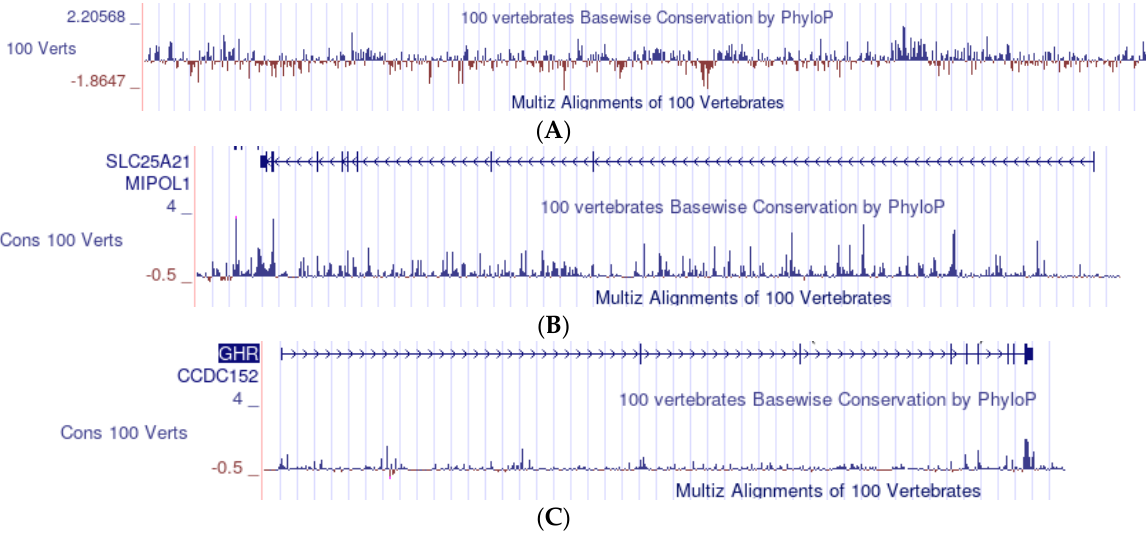
Figure 6. ( A ) An example of the analysis of conservation with the UCSC Genome Browser. The data, plotted as a bar graph, derive from the multialignment of 100 representative vertebrates. Each bar measures the average conservation/mutation of a series of 800 nucleotides; the blue bars (positive values) measure the conservation; the red bars (negative values) measure the mutation; the zero level is the conservation expected under neutral drift on the left of the scale (from −1.8647 to 2.20568). ( B ) SLC25A21: bar graph of the conservation profile in vertebrates. Each of the (minute) bars corresponds to 800 nucleotides. The series of arrows (top of the figure) indicate the direction of translation. The small vertical lines on the line of arrows mark the position of the exons. Other captions are the same as those in ( A ). ( C ) GHR: bar graph of the conservation profile in vertebrates. The same scale and other captions are used in ( B ), but each bar corresponds to 480